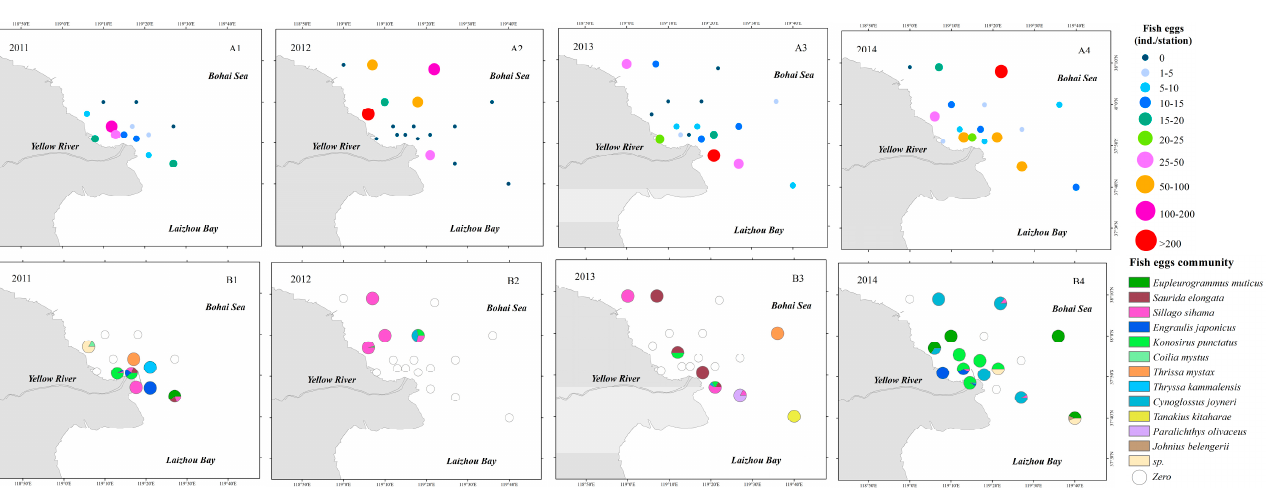
Figure 4. Spatial distribution of fish eggs collected in this study. ( A1 – A4 ), Fish egg abundances. ( B1 – B4 ), Fish egg communities. ( B1 – B4 ), Fish egg communities.